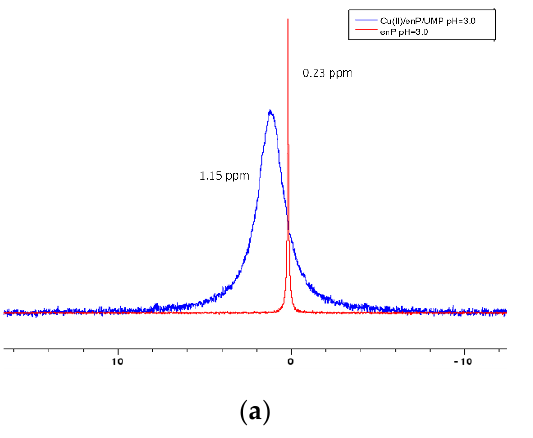
Figure 4. UV-Vis spectra of complexes in Cu(II)/enP/UMP system.